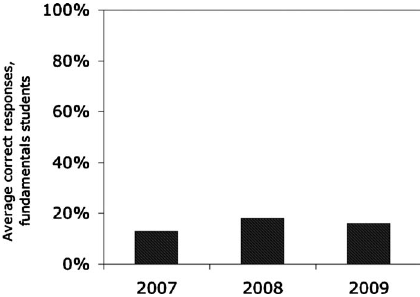
FIG. 5. Average correct responses for Fundamentals students preinstruction from 2007 to 2009.